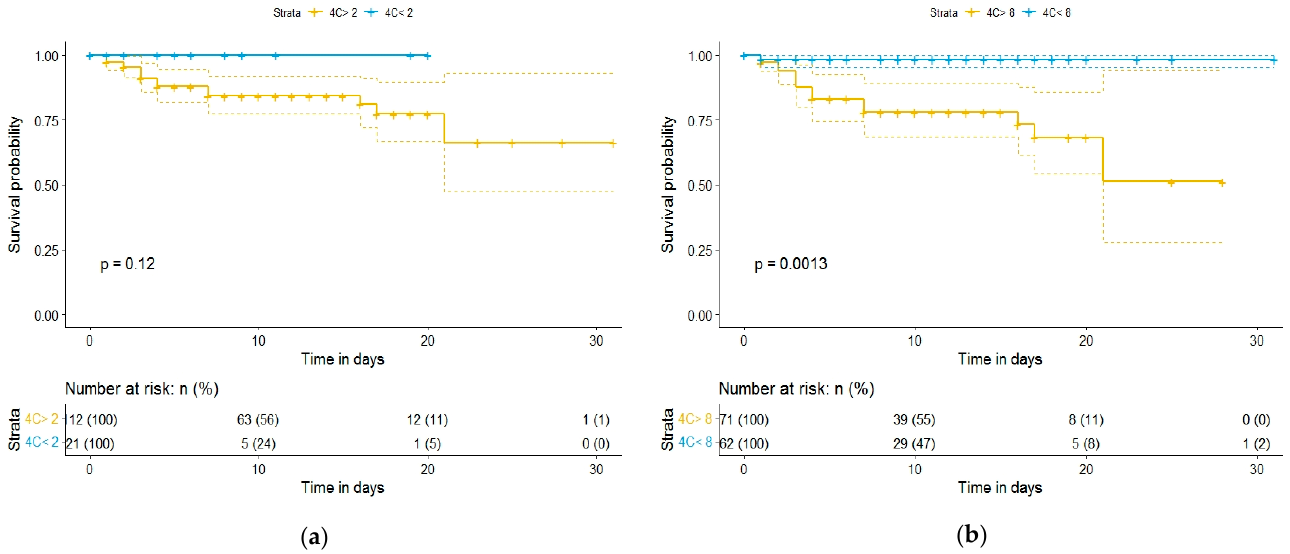
Figure 2. Kaplan–Meier survival curves of hospitalized COVID-19 patients: ( a ) according to 4C Mortality Score cutoff value of 2; ( b ) according to 4C Mortality Score cutoff value of 8.